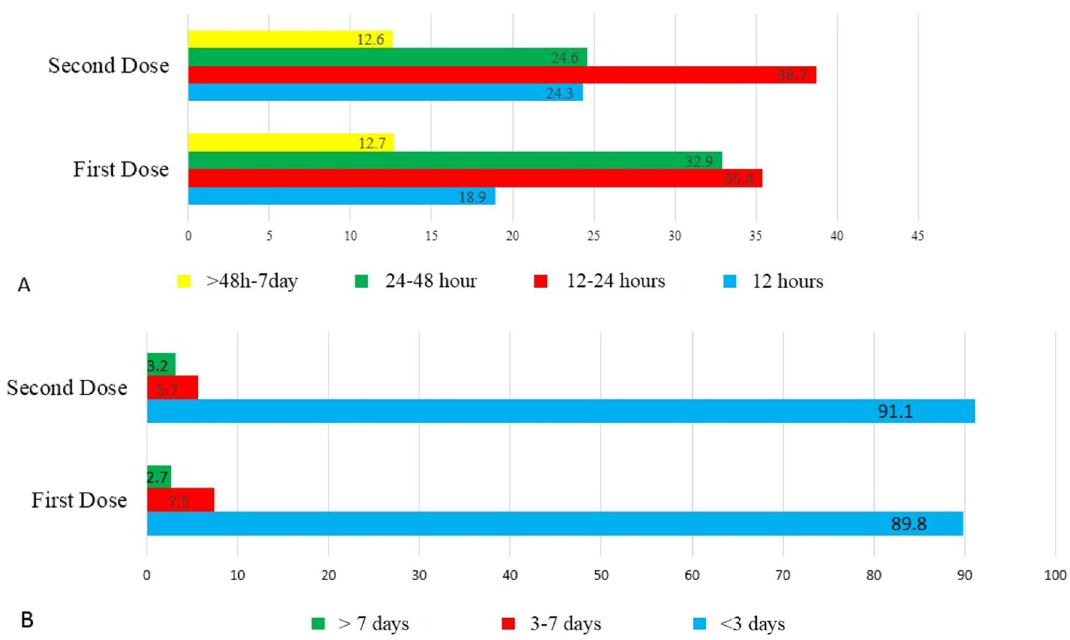
Figure 2. The onset ( A ) and duration ( B ) of side effects after first and second dose of Sputnik V COVID-19 vaccine. The numbers in the bars are in